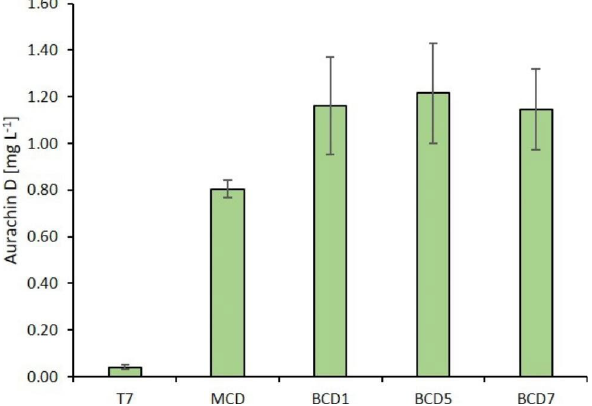
Fig. 4 Production of aurachin D in E. coli cultures expressing auaA under control of the T7 promoter or, alternatively, the trc* promoter using mono- and bicistronic design (MCD, BCD1, BCD5, BCD7)